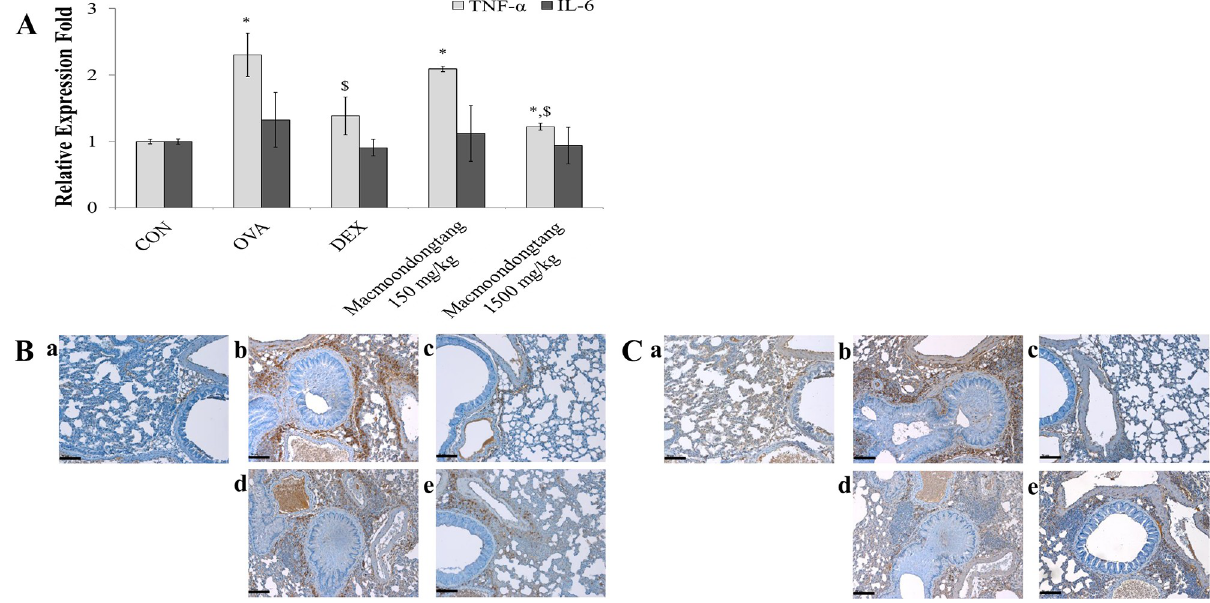
Fig 8. Macmoondongtang treatment significantly inhibited TNF- α gene and protein expression, but not that of IL-6. Macmoondongtang dose- dependently suppressed the gene (A) and protein expression (B) of TNF- α but not that of IL-6 expression (C). a , vehicle control; b , asthma induction; c , dexamethasone; d ,150 mg/kg/day macmoondongtang ; e , 1500 mg/kg/day macmoondongtang . Each bar represents the mean ± SD (n = 8). � p < 0.05 vs. control; $ p < 0.05 vs. asthma induction. Scale Bar = 50 μ m. Magnification, × 200.